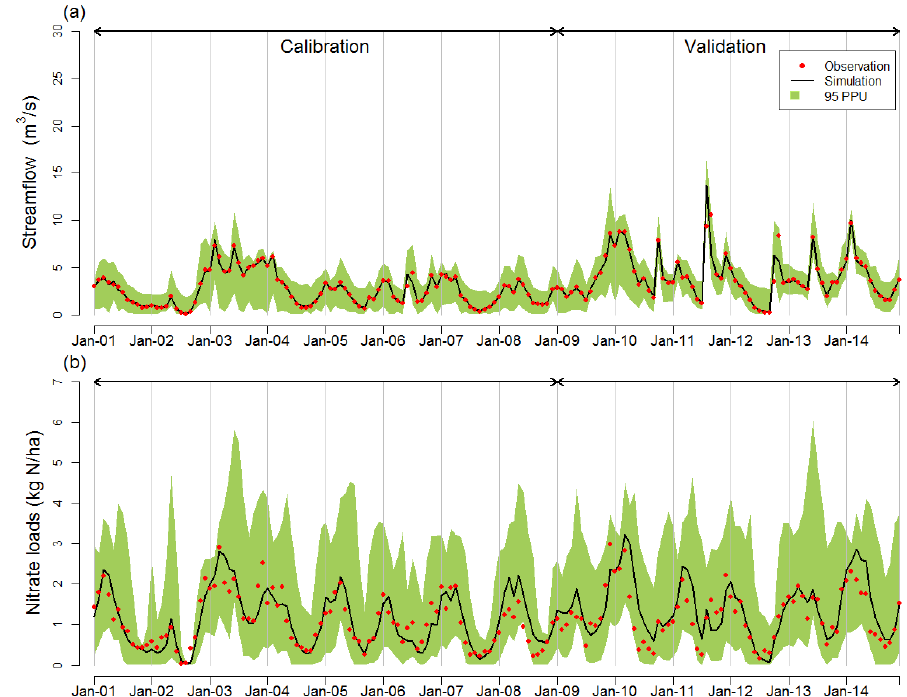
Figure 2. Comparison of observed and simulated monthly ( a ) streamflow and ( b ) nitrate loads under the baseline period.